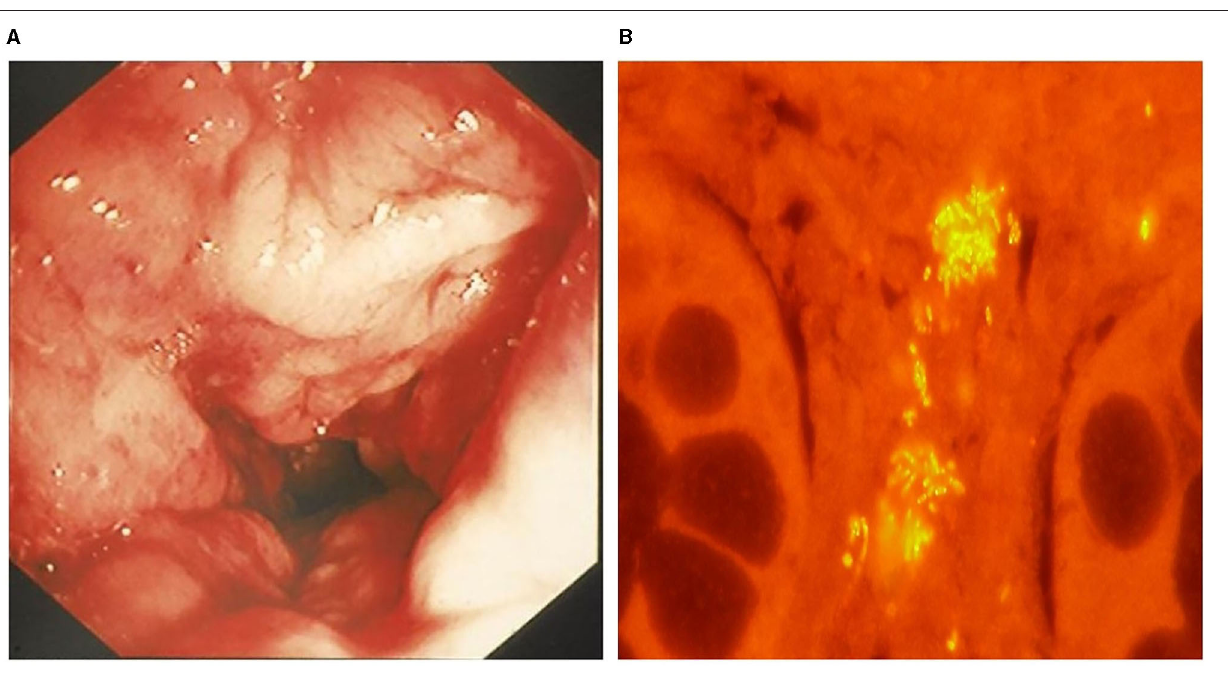
FIGURE 5 | Granulomatous colitis in a 2-year-old English bulldog. (A) Endoscopic image of severe colonic granularity (increased texture) involving the descending colon. (B) Colonic biopsy from this dog shows clusters (yellow fluorescence) of mucosal associated E. coli following fluorescence in situ hybridization. From: Jergens et al. (125), with